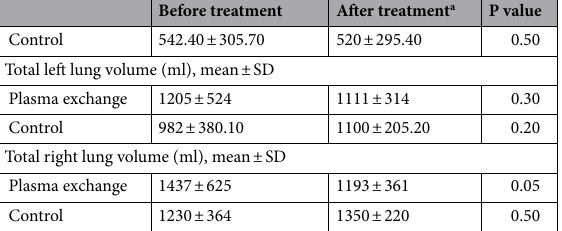
Table 2. Clinical, biochemical and tomographic characteristics before and after receiving PLEX. PLEX, plasma exchange therapy. a 5–7 days after treatment. b Evaluated 7–10 days